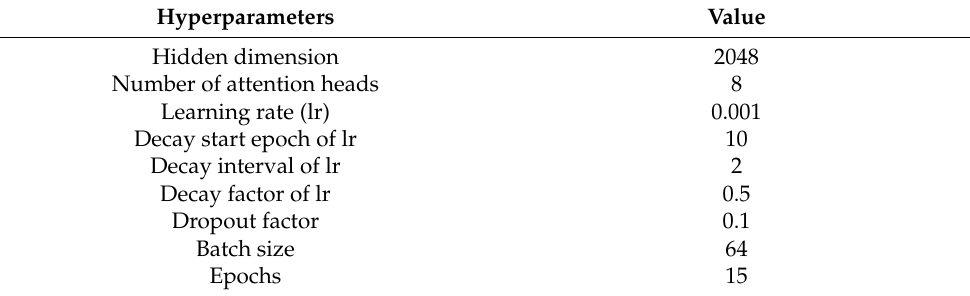
Table 1. Setting of